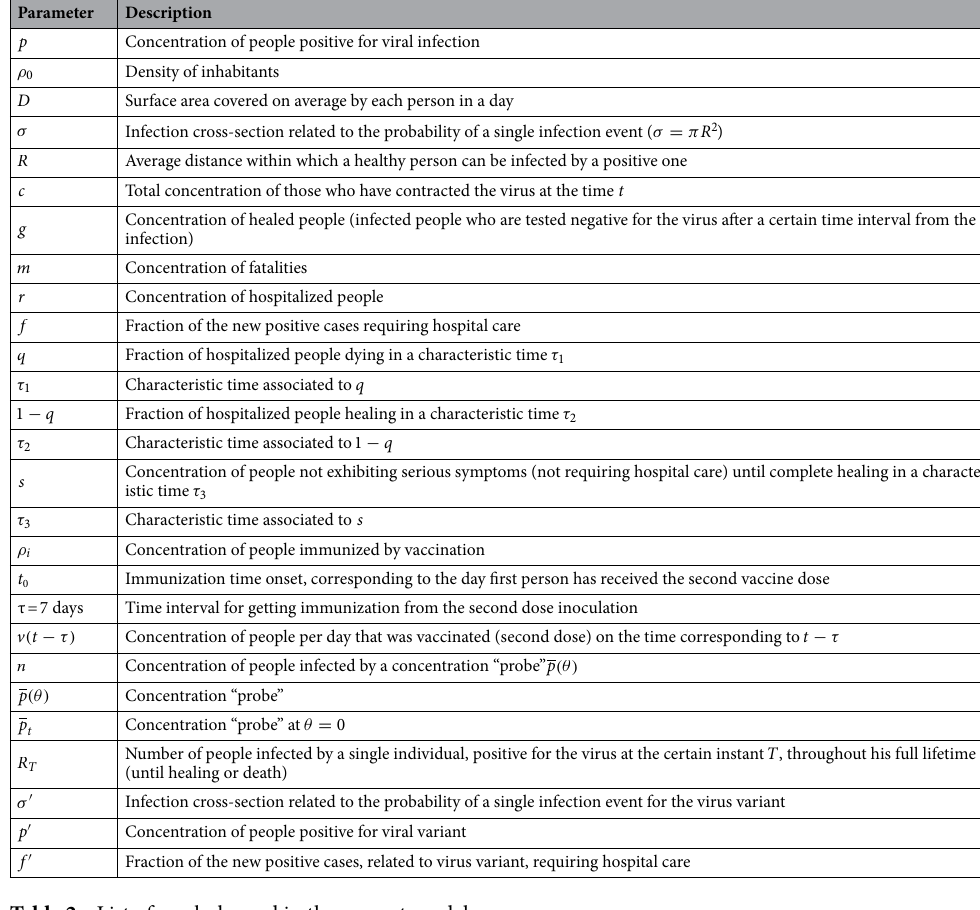
Table 2. List of symbols used in the present